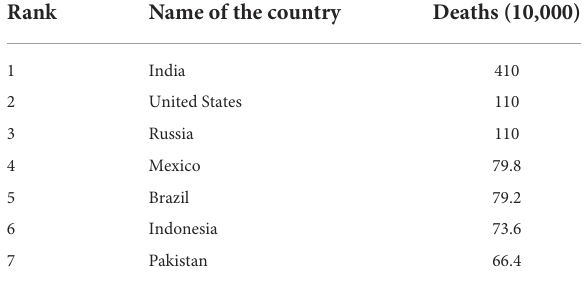
TABLE 3 Ranking of excess deaths from new coronary pneumonia by country. Rank